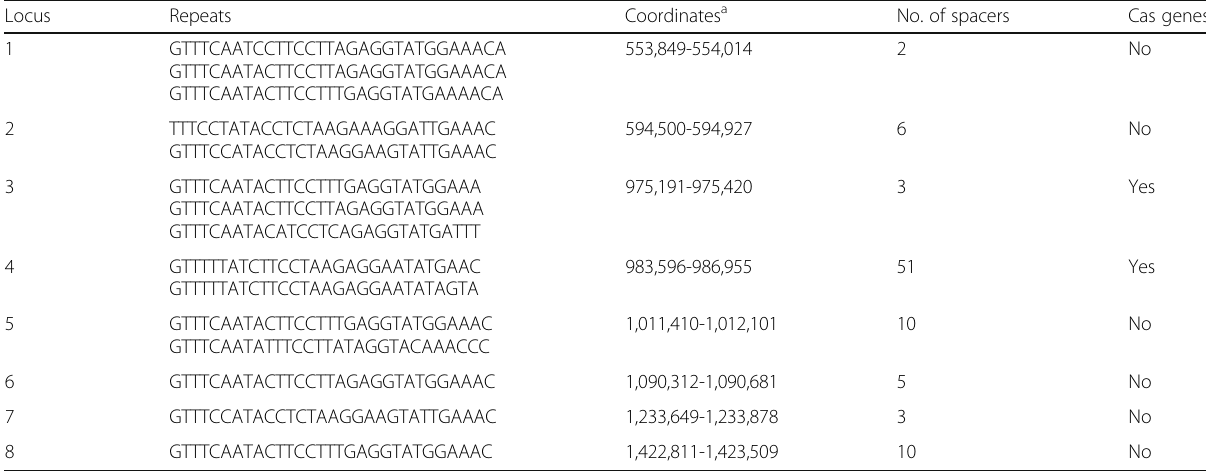
Table 7 Summary of CRISPR loci in T. sp. strain